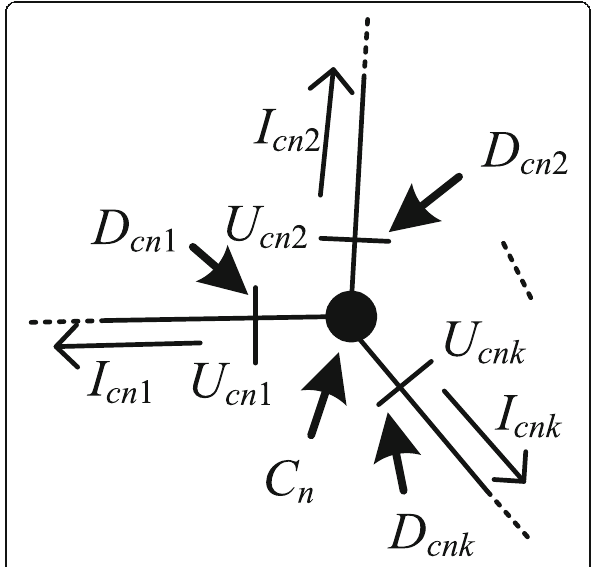
Fig. 3 Network node and its information nodes